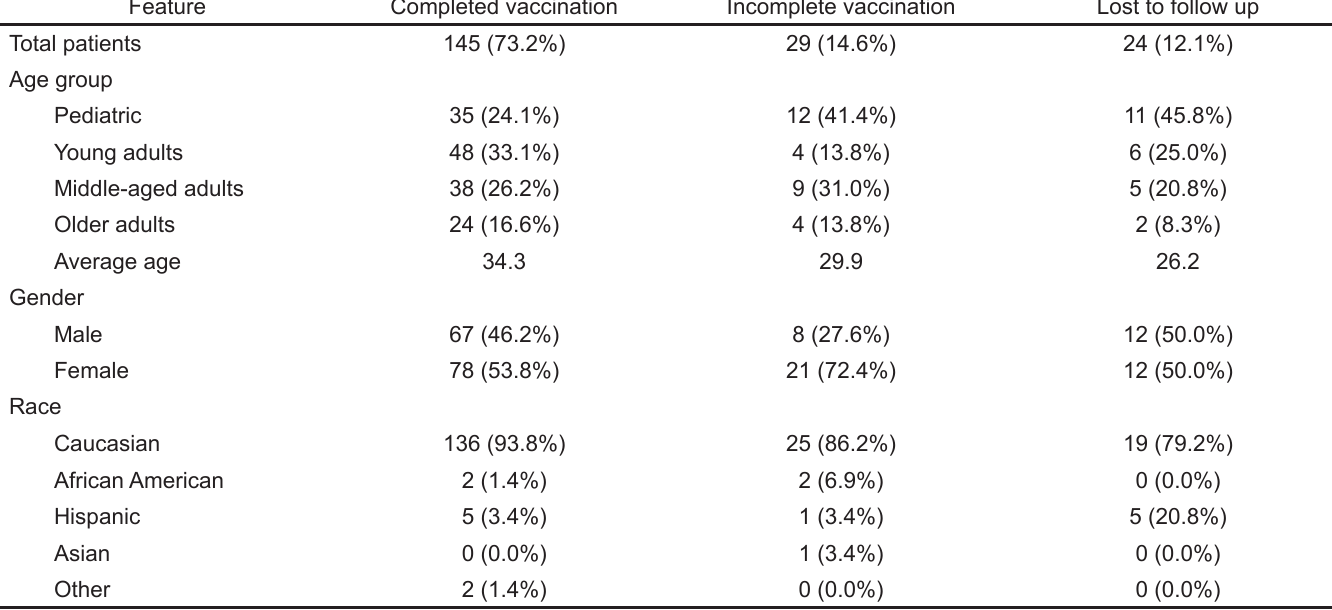
Table 1. Treatment outcome and patient demographics of patients exposed to possible rabies infection.